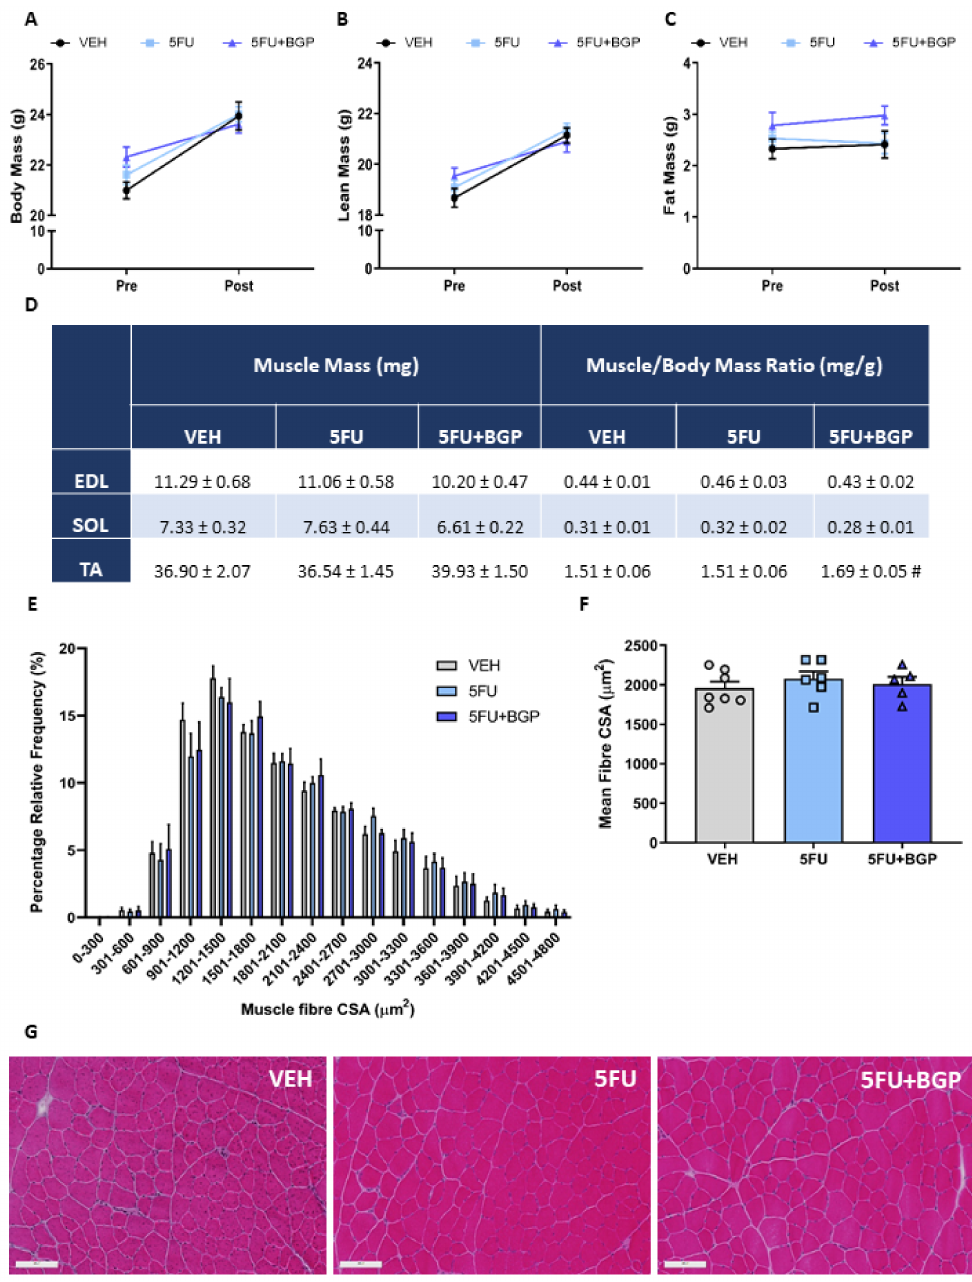
Figure 1. The effect of 5-fluorouracil (5FU) and 5FU with BGP-15 (5FU+BGP) treatment on body composition and muscle size indices. Body composition parameters were measured and presented as pre- and post-treatment data points for ( A ) body, ( B ) lean and ( C ) fat mass. ( D ) Hindlimb skeletal muscles extensor digitorum longus (EDL), soleus (SOL), and tibialis anterior (TA) were weighed post-treatment and data presented as raw mass and muscle to body mass ratios (# p = 0.07; compared to 5FU). TA cross-sections were H&E-stained and underwent histological fibre size analysis with data presented as ( E ) percentage relative frequency distribution of the muscle fibre cross-sectional area (CSA) and ( F ) mean muscle fibre CSA. ( G ) Representative images of H&E-stained TA cross-sections are displayed. Scale bar = 100 µ m. n = 7–8 for body composition indices; n = 4–8 for muscle weights; n = 5–7 for histology. Data are mean ±